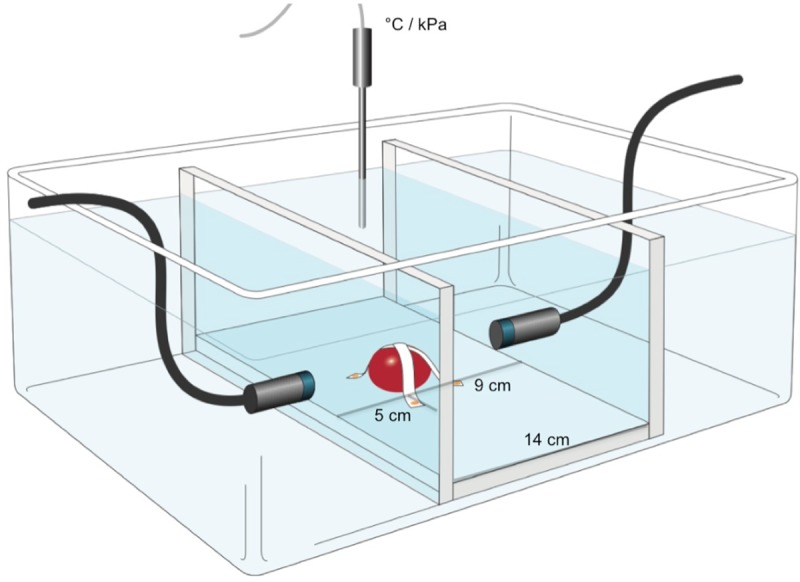
Experimental setting.All blood clots were submerged and fixed 10 cm below the water surface in a water bath (37°C), protected water tightly in a balloon in order to imitate an intracranial setting. The Doppler probes placed vis-à-vis were fixed in a Styrofoam board targeting the blood clot. Using one probe the clot was installed at a distance of 5 cm from the probe, which is a typical distance of an ICH of the basal ganglia to the temporal bone window. In case of using 2 probes, they were installed orthogonally and the second probe was fixed in a Styrofoam board at a distance of 9 cm to the clot, assuming a virtual head diameter of 14 cm. In the water bath temperature or APRP was measured at different target points.